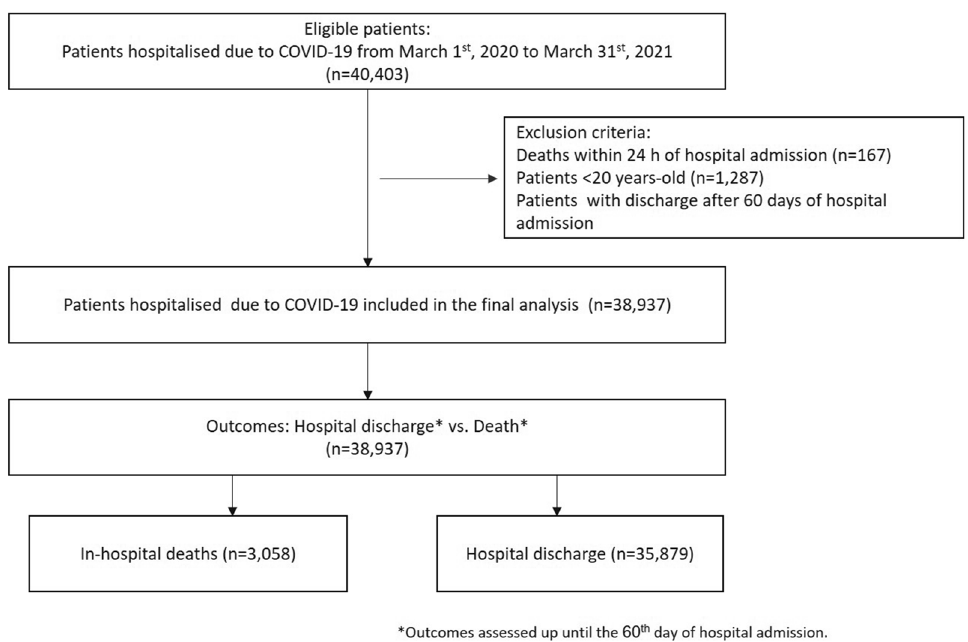
Figure 3. Diagram showing patient exclusions and the distribution of patients included in the final analysis according to outcomes (i.e. in-hospital death vs. hospital